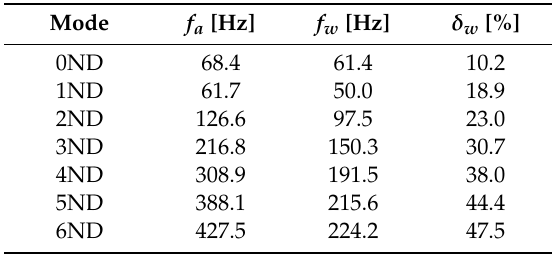
Table 6. Natural frequencies in air ( f a ) and in water ( f w ), and frequency reduction ratios ( δ w ) of the runner modes from 0 to 6 nodal diameters (ND).